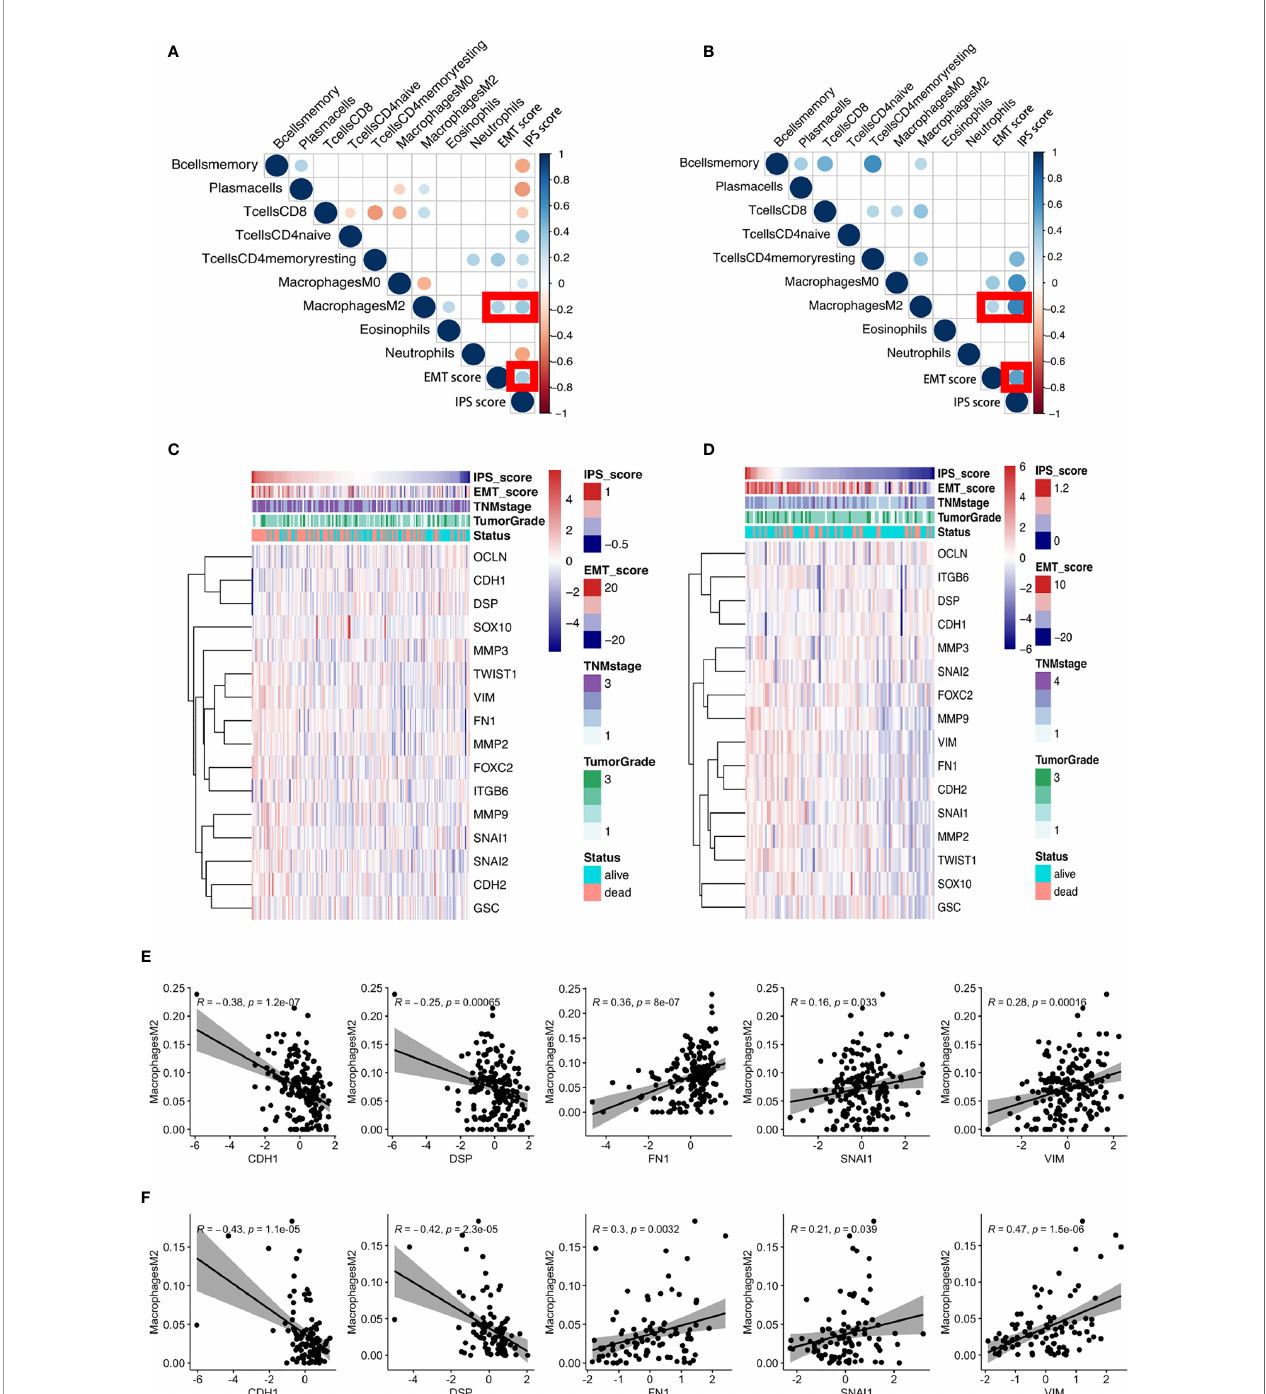
FIGURE 4 | The signi fi cant positive relationship between the IPS score and the EMT score and the critical role of M2 macrophages in the relationship between the IPS and the EMT process. (A, B) Correlation matrix plots of the correlations between the IPS score, EMT score, and the nine constituent cell types in the IPS in the GEO training set and TCGA validation set. The color of the circle represents the R-squared value of the Spearman correlation analysis. The size of the circle represents the p-value of the correlation; a larger circle represents a smaller p-value, and vice versa. All p-values > 0.001 were fi ltered from the plots. (C, D) Heatmaps of the expression of sixteen canonical EMT genes, IPS scores, EMT scores, and relative clinicopathological features in the GEO training set and TCGA validation set. (E, F) The correlations between M2 macrophage abundance and the IPS score, EMT score, and expression of 16 canonical EMT genes in the GEO training set and TCGA validation